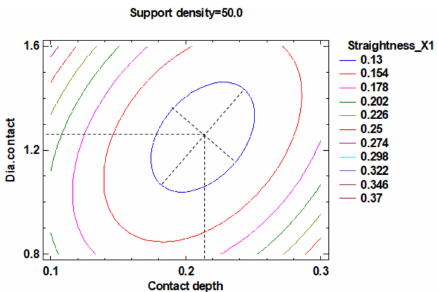
Figure 16. Contours of Estimated Response Surface for Straightness_X1 and centre support density.